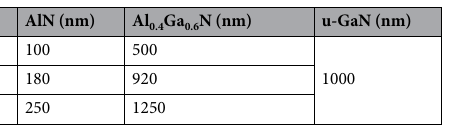
Figure 1. Schematic illustrations of ( a ) the growth procedure of freestanding GaN crystals grown on Si substrates and ( b ) its sequence in HVPE reactor. No. AlN (nm) Al 0.4 Ga 0.6 N (nm) u-GaN (nm)